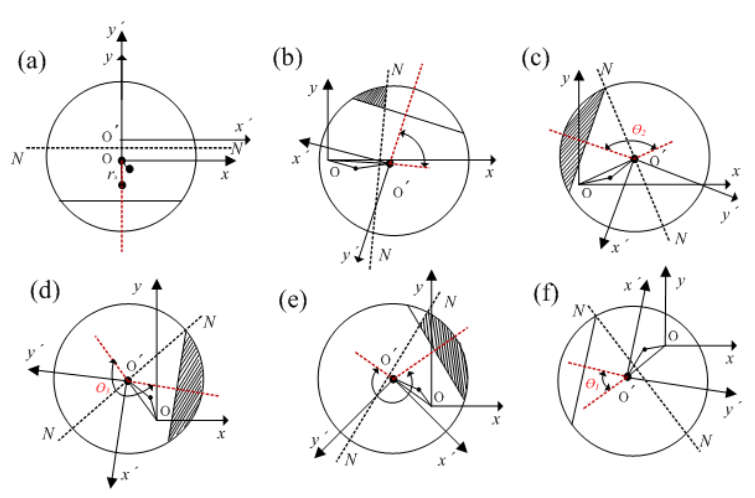
Figure 2. States of breathing crack for different angles of rotating.